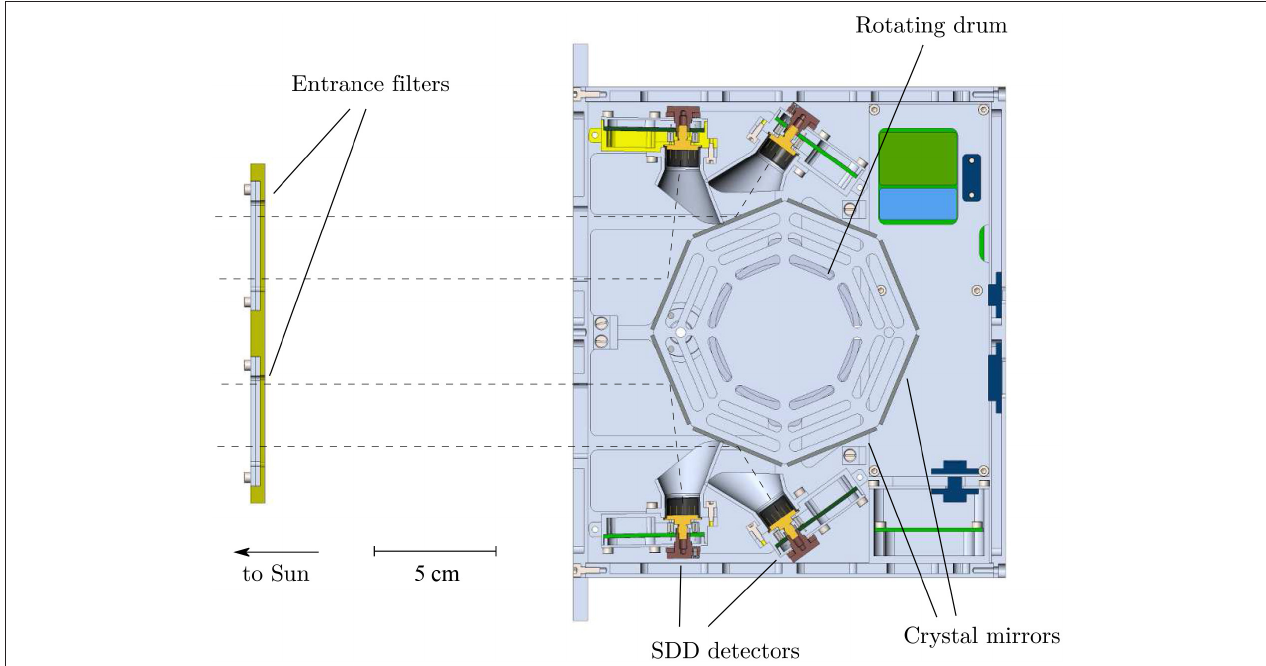
FIGURE 5 | A cross sectional view of the Rotating-Drum Spectrometer (RDS) inside the KORTES-SU assembly. The drum with eight crystals is rotating at 10 turns per second. The solar radiation reflected from the crystals is registered by four SDD-detectors placed symmetrically in a Dopplerometer configuration.